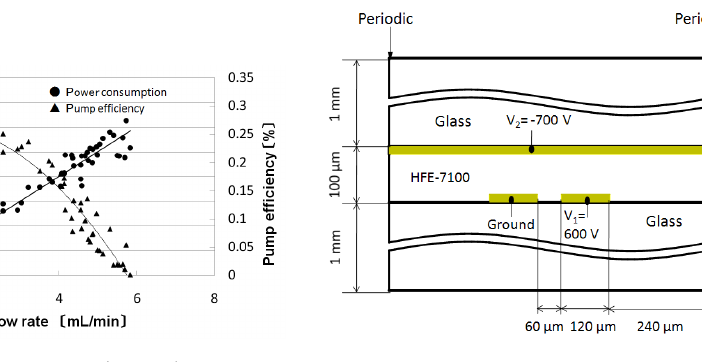
Fig. 17 Illustration of the pumping 1